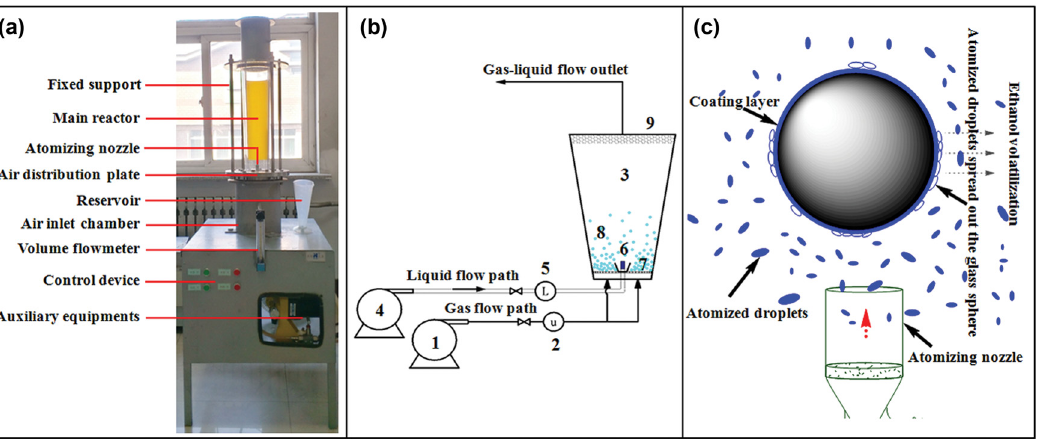
Figure 1: Bottom - spray fl uidized bed reactor system: ( a ) experimental rig; ( b ) fl ow diagram: ① fan, ② anemometer, ③ bottom - spray fl uidized bed reactor, ④ diaphragm metering pump, ⑤ volume fl owmeter, ⑥ atomizing nozzle, ⑦ air distribution plate, ⑧ glass spheres, ⑨ super fi ne mesh; ( c ) schematic diagram for the bottom - spray coating